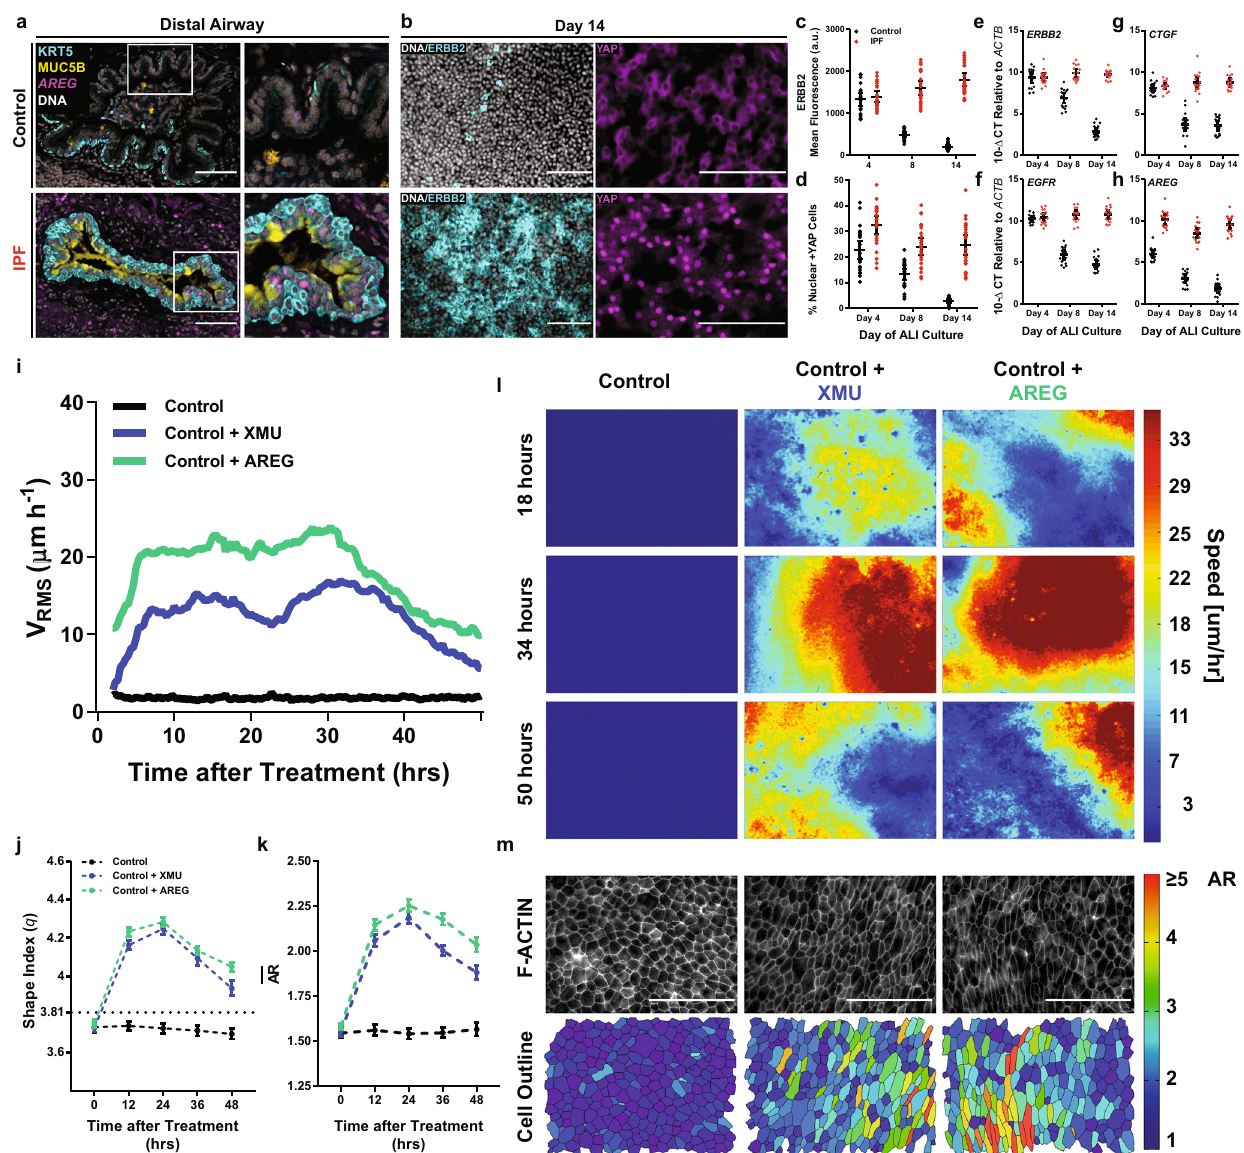
Fig. 2 EGFR and YAP activation induce unjamming in airway epithelia. Representative distal airway epithelial cells were stained for KRT5 and MUC5B protein, and AREG mRNA in control or IPF ( a ) patient samples with increased AREG present in the IPF epithelium. Representative images of control or IPF distal epithelia stained for ERBB2, or YAP ( b ) demonstrate increases in ERBB2 protein and YAP nuclear localization in IPF distal epithelia. This difference in ERBB protein ( c ) and YAP nuclear localization ( d ) was most pronounced at later ALI days with protein/localization differences becoming most apparent as control distal epithelia entered the jammed state. These protein level changes were also accompanied by signi fi cant gene level changes in ERBB family receptors EGFR ( e ) and ERBB2 ( f ) as well as YAP target genes AREG ( g ) and CTGF ( h ) with control epithelial differences becoming pronounced on day 8, across the jamming transition. Control epithelia from distal airways on day 14 of ALI were treated with XMU (a small molecule YAP activator) or AREG (an EGFR ligand) to elicit unjamming of the static, quiescent epithelium. Upon treatment, XMU and AREG elicited a collective migratory phenotype as measured by root-mean-squared velocity V RMS ( i ). This induced unjammed state was also quanti fi ed via cell shape changes with the perimeter-to-area (q) ( j ) and aspect ratios ( k ), cells were analyzed every 12h after treatment was initiated. Representative speed maps taken every 16h after treatment ( l ) and cell boundary segmentation at 48h after treatment ( m ) demonstrated concordant migration and cell body elongation consistent with the induction of an unjammed state. Shown: mean ± 95% con fi dence interval for n = 4 donors (control epithelia) and n = 3 donors (IPF epithelia) with (cid:2) 2 replicates per donors and scale bars representing 100 μ